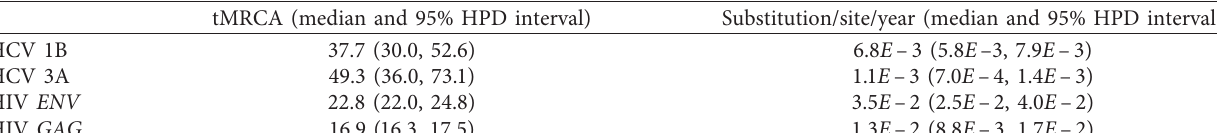
Table 5: tMRCA and Substitution rate of HCV and HIV.